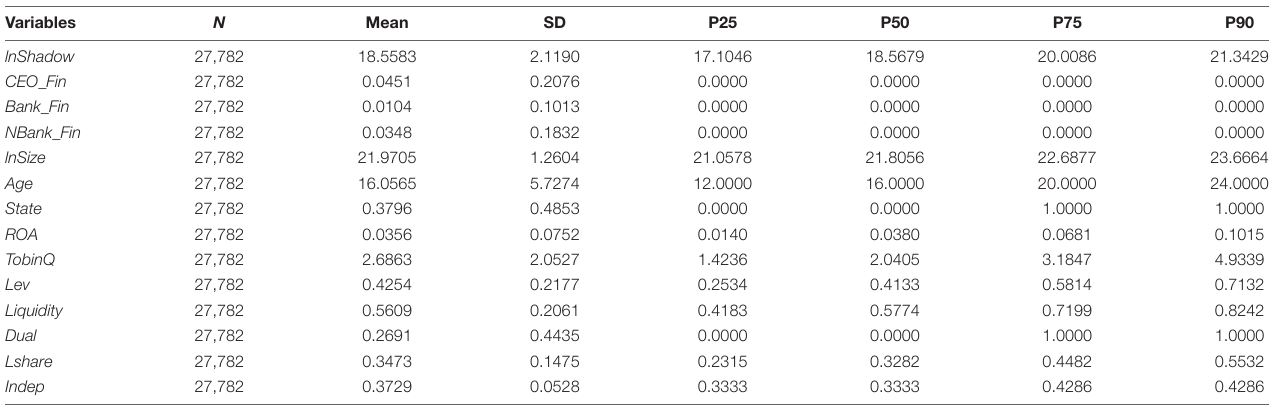
TABLE 2 | Descriptive statistical results of major variables.